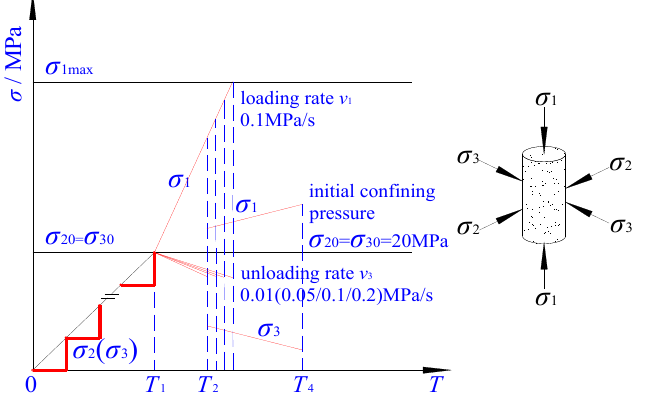
Figure 3. The stress path of unloading confining pressure and increasing the shaft